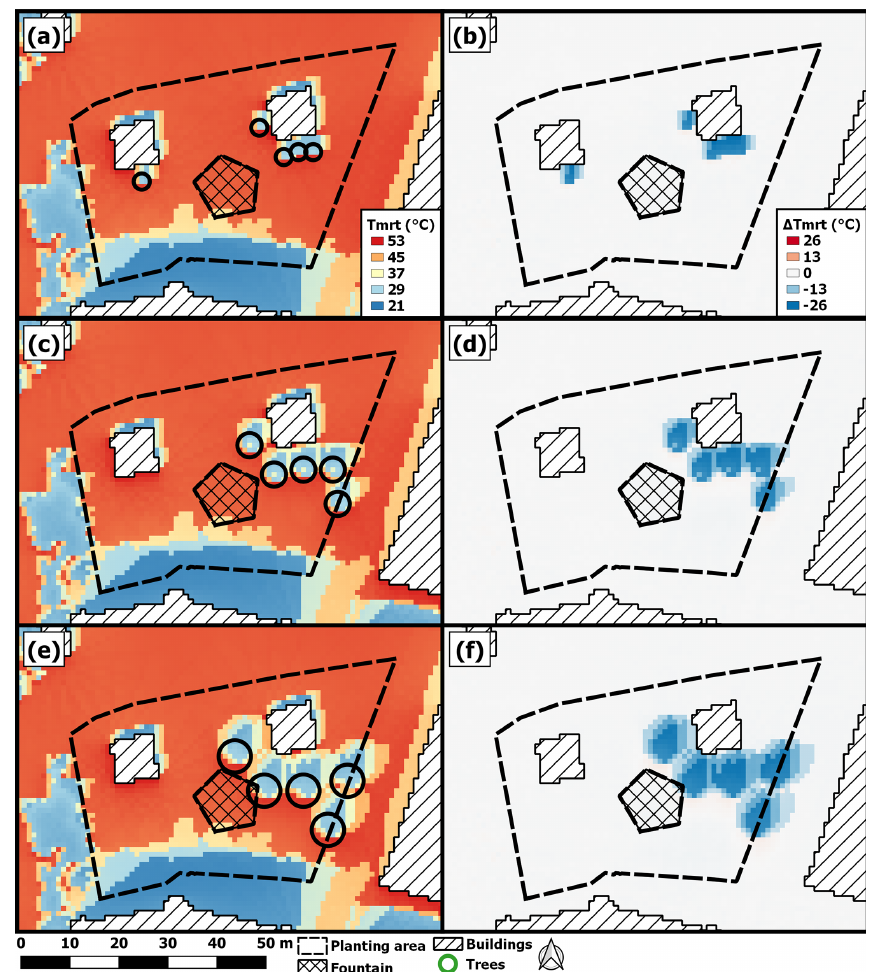
Figure 5. Mean T mrt for 13:00–16:00LST on 22 June 1983, with locations of (a) five small trees, (c) five medium trees and (e) five large trees in green (Table 1). Panels (b) , (d) and (f) show corresponding differences in T mrt between tree shade and sunlit areas for panels (a) , (c) and (e) , respectively. The positions are determined with the genetic starting algorithm and 20000